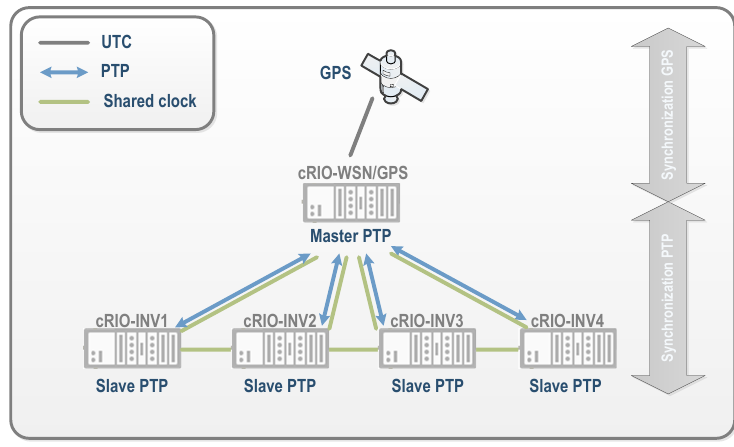
Figure 12. Synchronization system scheme. UTC: Universal Time Coordinate; PTP: Precision Time Protocol; GPS: Global Positioning System; cRIO: CompactRIO programmable controller; INV: Inverter; WSN: Wireless Sensor